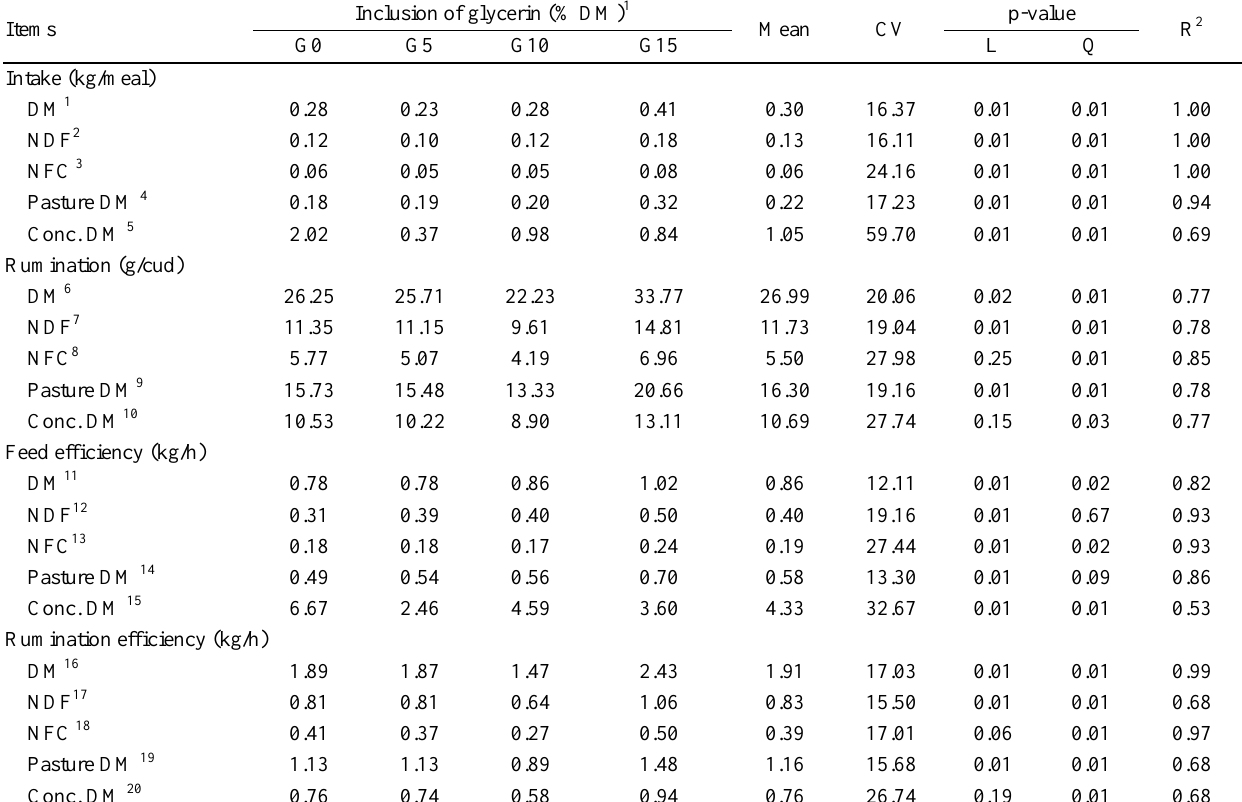
Table 7. Effect of the levels of glycerin on intake, rumination, and feed and rumination efficiencies in supplemented heifers on a Brachiaria brizantha